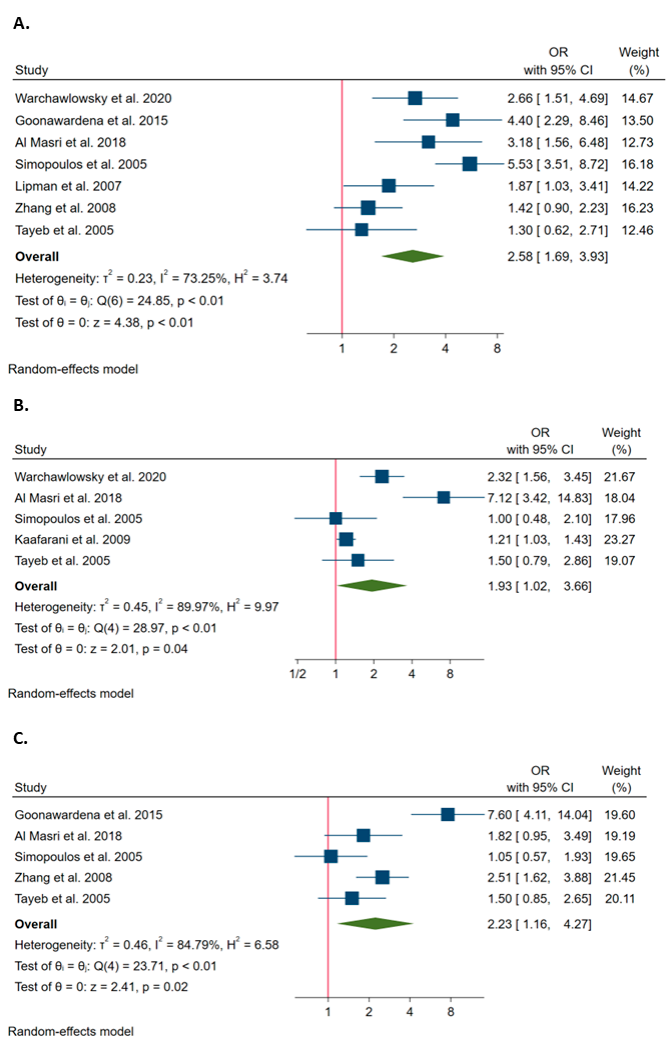
Figure 5. Forest plots of the associations of diabetes ( A ) [3,4,17,23,25,28,49], hypertension ( B ) [3,4,23,25,43] and obesity ( C ) [4,23,25,28,49] with the probability of conversion . The graph ( A ) shows the ORs for the comparison between patients with diabetes and those without it (reference group). The graph ( B ) shows the ORs for the comparison between patients with hypertension and those without it (reference group). The graph ( C ) shows the ORs for the comparison between obese and non-obese patients (reference group).